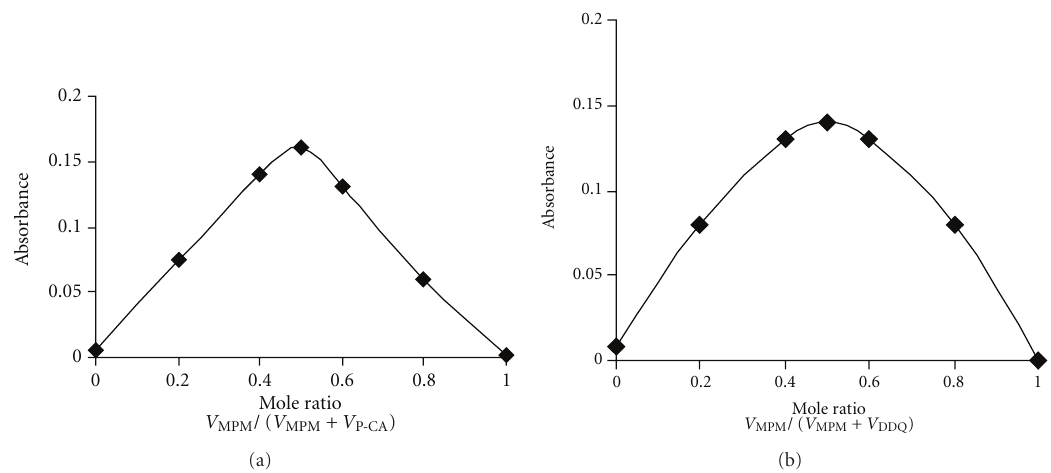
Figure 4: Job’s plots obtained for (a) 4.61 × 10 − 4 M MPM and p-CA C-T complex and (b) 2.31 × 10 − 4 M MPM and DDQ C-T complex.